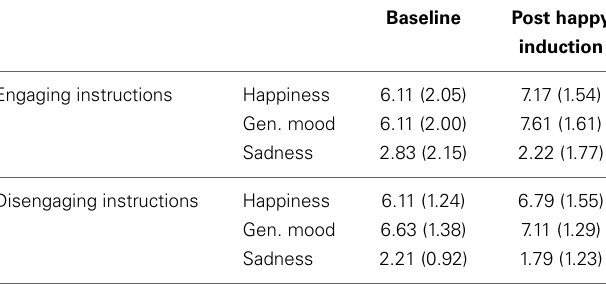
Table 2 | Means and SD ’s (in parenthesis) of self reported happiness, general mood, and sadness ratings in Study 2, in the different emotional engagement